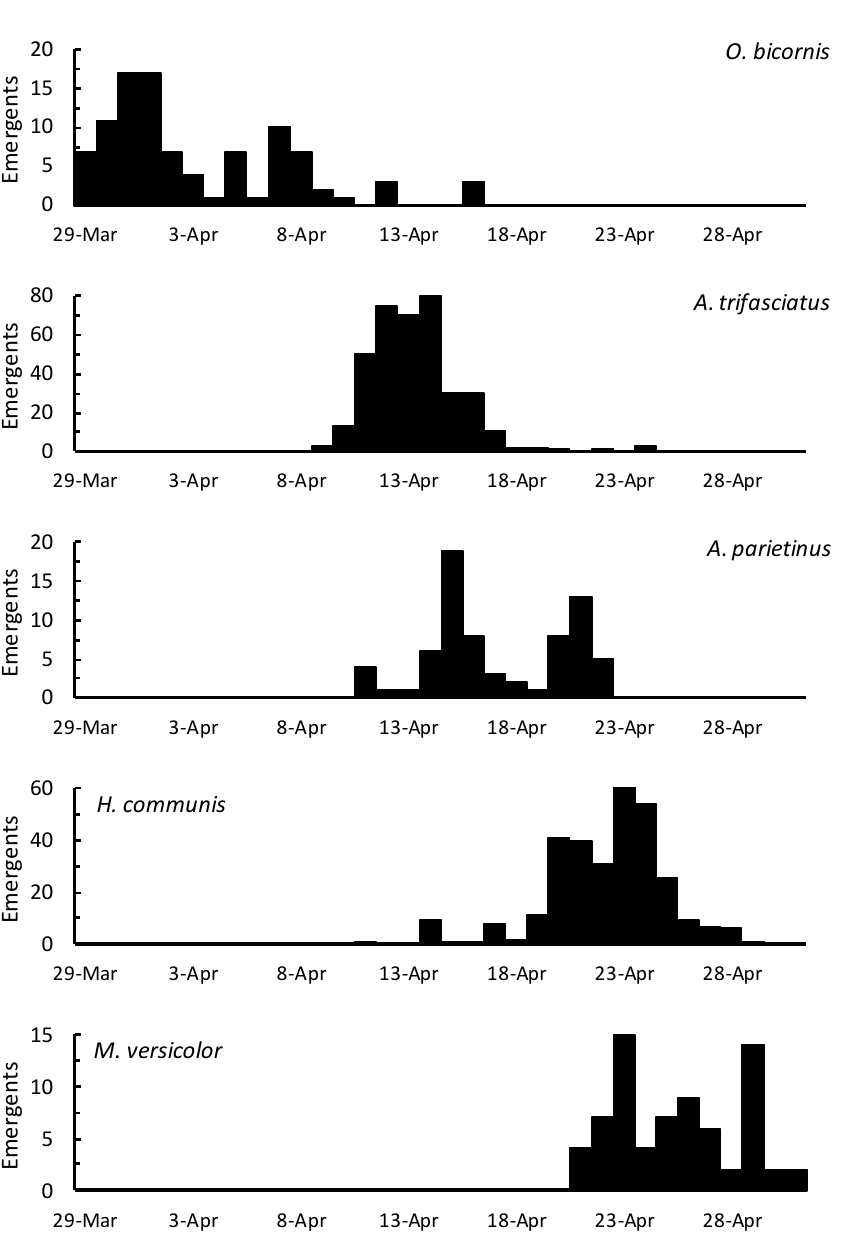
Figure 3. Total numbers of stem- nesting Hymenoptera emerging each day from cardboard nest tubes from March 29 th to 1 st May The nest tubes were placed out at 16 Irish farms during spring/summer